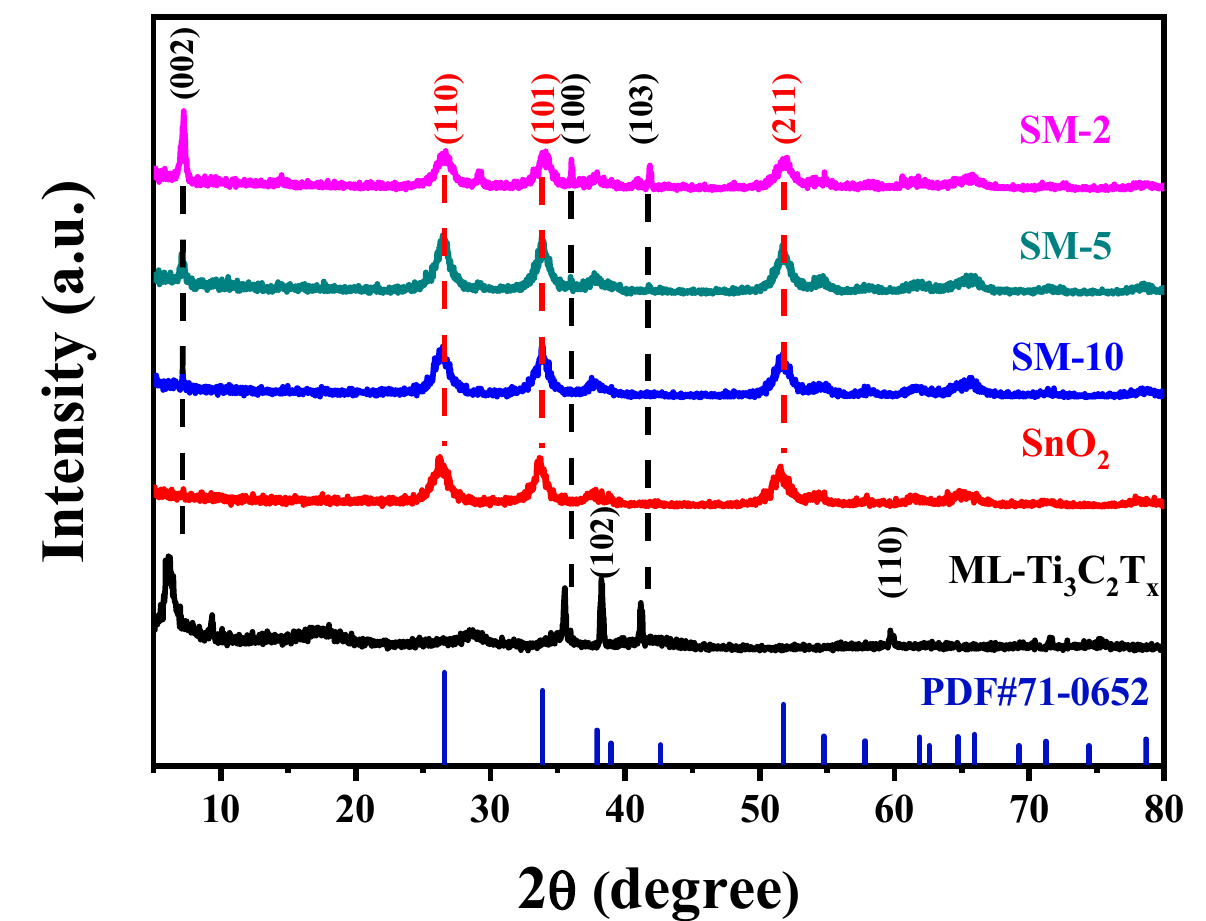
Figure 2. XRD diffraction patterns of as-prepared samples.